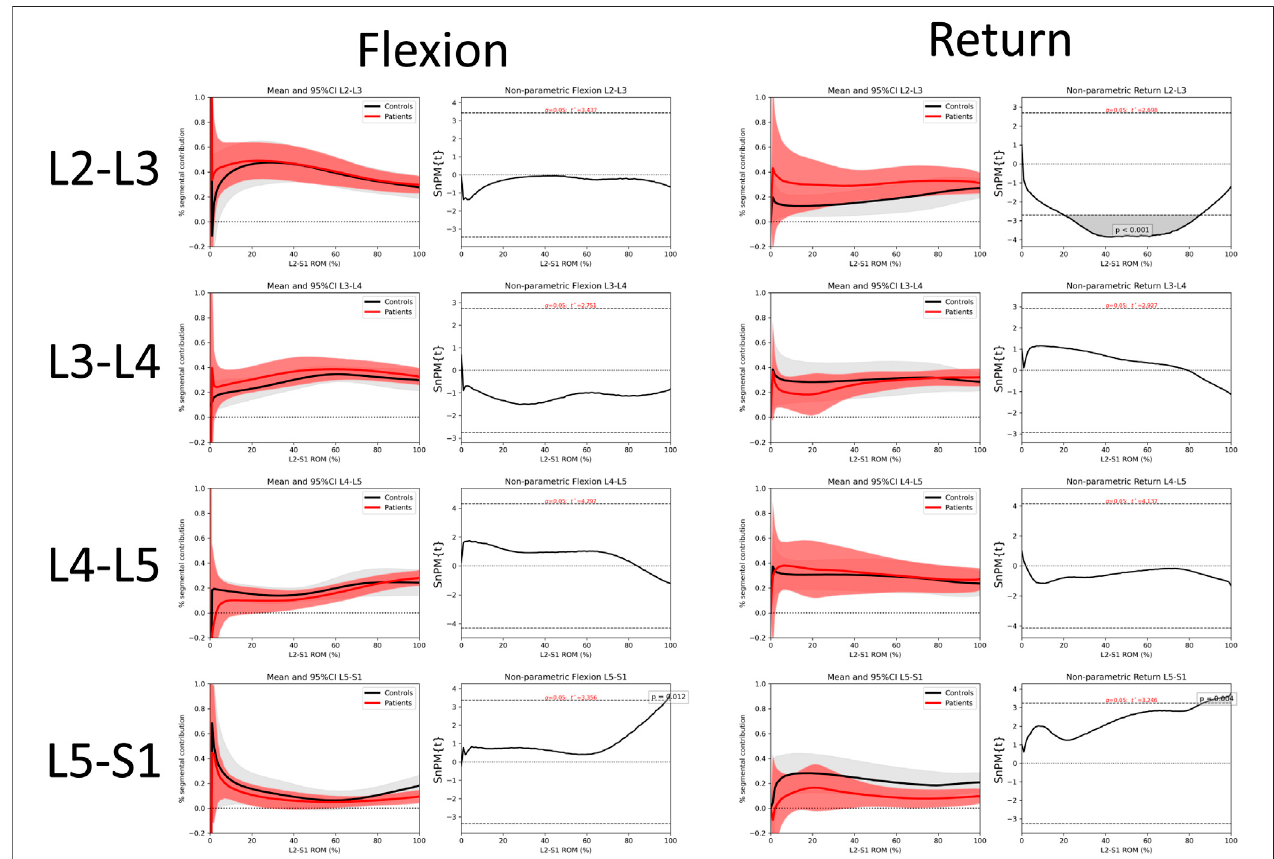
FIGURE 6 | Comparison of intervertebral motion sharing patterns between patients and controls at individual levels for fl exion and return with 95% con fi dence intervals and SPM. Comparisons for all inter-joint combinations are shown in Supplementary Material III .